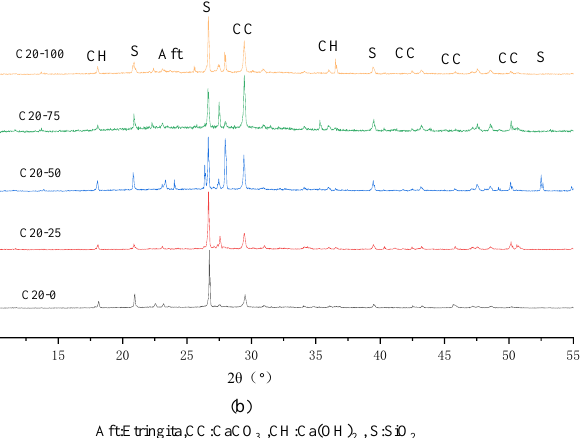
Figure 6. XRD analysis results of C20 concrete.( a ): Curing ages (7 days); ( b ): Curing ages(28 days).